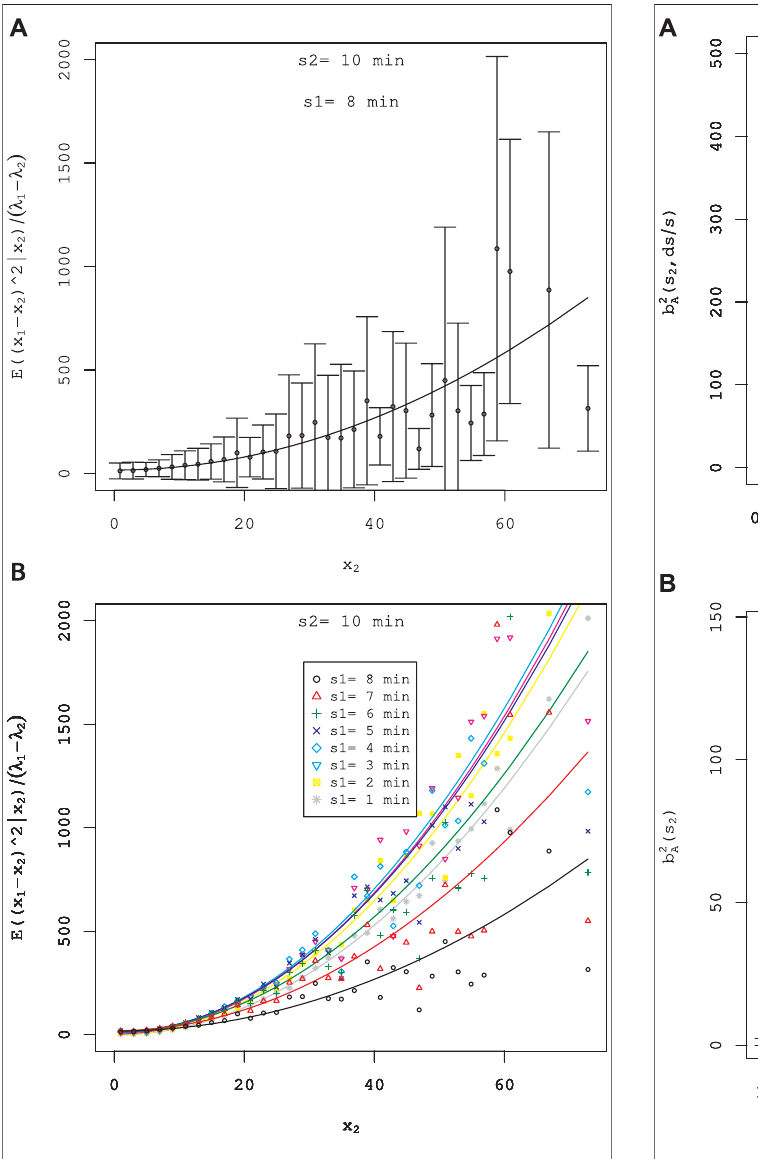
FIGURE 7 | Estimation of the parameter b A ( s ) . (A) The parameter b A ( s 2 , ds / s ) obtained by the regressions shown in Figure 6 and nonlinear fi tting log ( b 2 ( s , ds / s )) (cid:2) a + b ( ds / s ) + c ( ds /s ) 2 . The standard errors of the A regression Eq. 31 are denoted by an error bar. (B) b 2 A ( s ) (cid:2) exp ( a ) (see the text). Standard errors of nonlinear fi ttings are denoted by an error bar. The solid line shows the least-squares fi t of b 2 A ( s ) to the power law function.